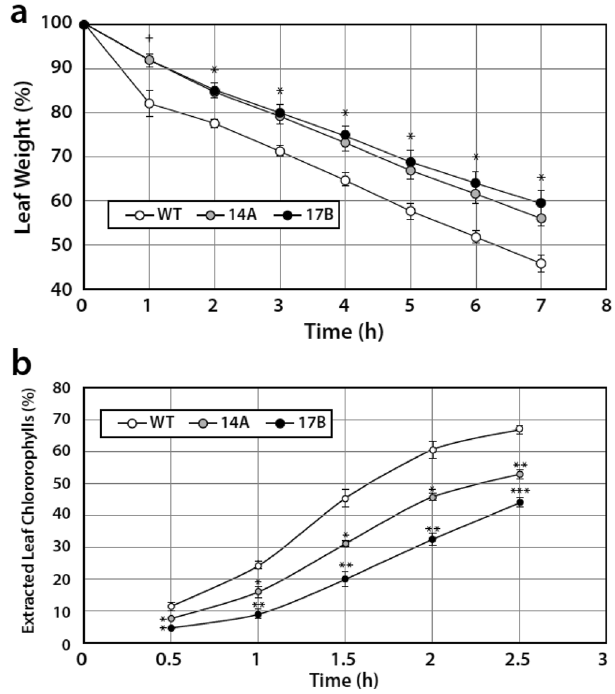
Figure 8. Leaves from the transgenic lines 14A and 17B show decreased cuticle permeability compared to wild- type (WT). Cuticle permeability assays using detached V3 stage leaves of WT and transgenic lines 14A and 17B. ( a ) Water loss assay (+p ≤ 0.05; *p ≤ 0.01) and ( b ) Chlorophyll leakage assay (*p ≤ 0.05; **p ≤ 0.01; ***p ≤ 0.001). Data represent means ± SE (n = 3), with statistical differences based on the Student’s t